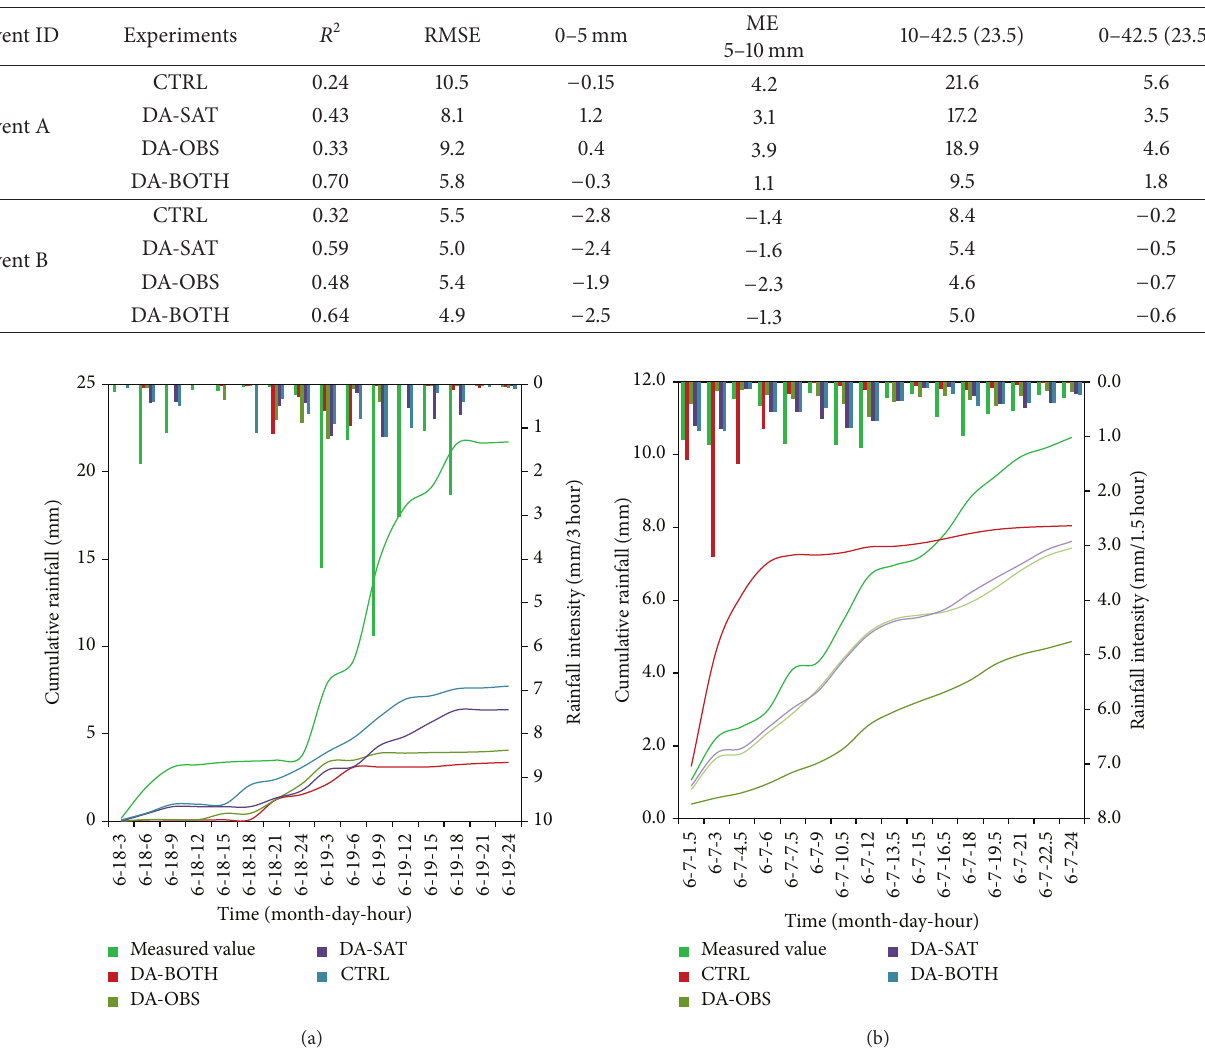
Table 3: Differences between observation and numerical experiments.